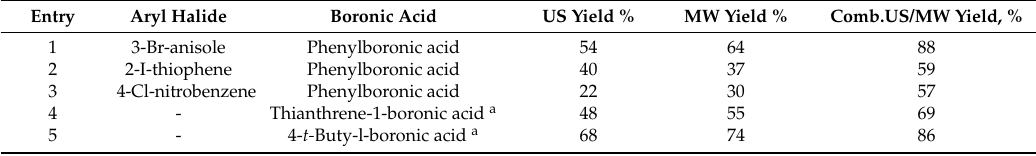
Table 1. Compared yields of Suzuki reactions under US or MW alone and under combined US/MW. Entry Aryl Halide Boronic Acid US Yield % MW Yield % Comb.US/MW Yield,